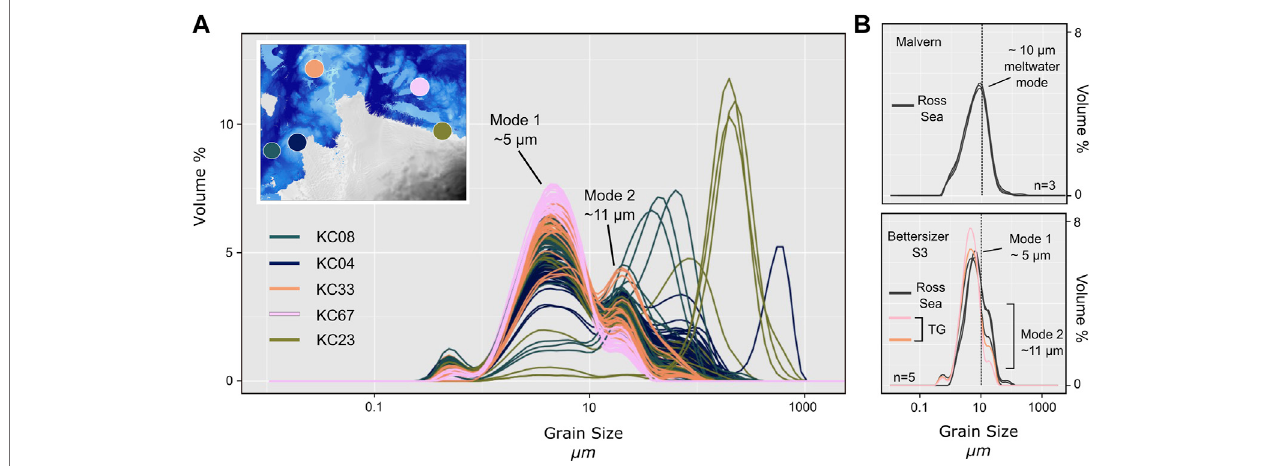
FIGURE 2 | Grain-size distributions of sediment core samples ( n = 196) on a semi-log axis plotted against volume percent. Core locations are denoted by color in theinsetmapinpanel (A) . (A) Allsamplesexhibitvaryingdegreesof~5micronMode1and~11micronMode2,similartomeltwaterdepositsdescribedelsewherealong the continental shelf in the Paci fi c Sector of Antarctica. (B) Instrumental comparison for grain-size distributions of previously published meltwater deposits from the westernRossSea(seeinsetin Figure1A )collectedduringcruisesNBP98-01(KC5426 cm)andNBP1502(KC17170 cm;KC2479 cm)andpublishedinProthro et al. (2018) and Simkins et al. (2017). In the lower panel are samples KC33 200 – 202 cm and KC67 50 – 52 cm from Thwaites Glacier (TG) shown for